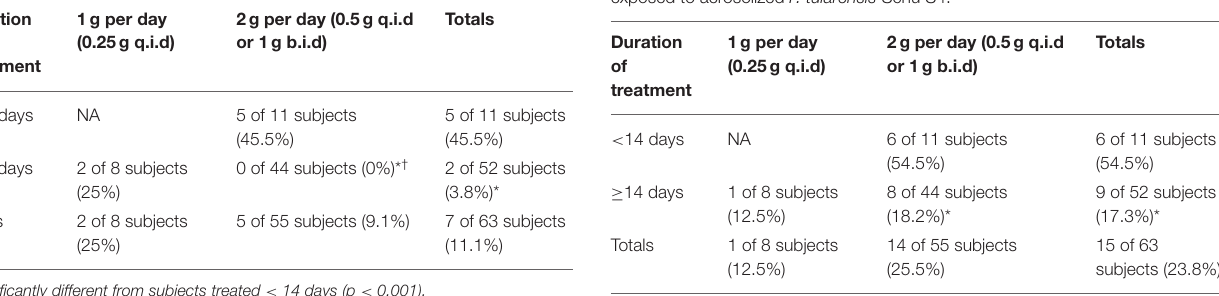
TABLE 4 | Percent of subjects showing re-appearance of more than 1 adverse event after termination of tetracycline treatment in operation whitecoat subjects exposed to aerosolized F. tularensis Schu